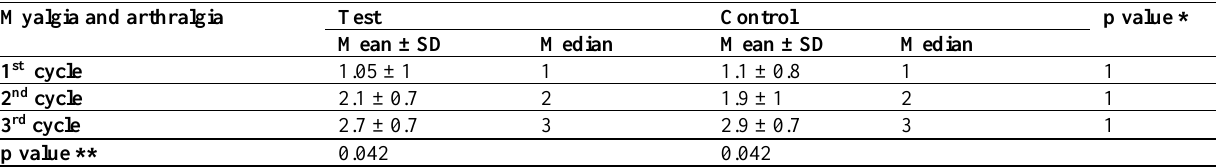
Table 3: Myalgia and arthralgia in both groups using NCI -CTCAE 4.0. Myalgia and arthralgia